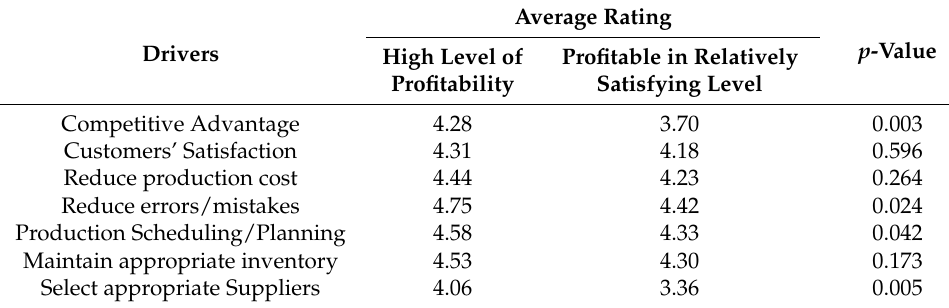
Table 5. Barriers of IS adoption—level of profitability.